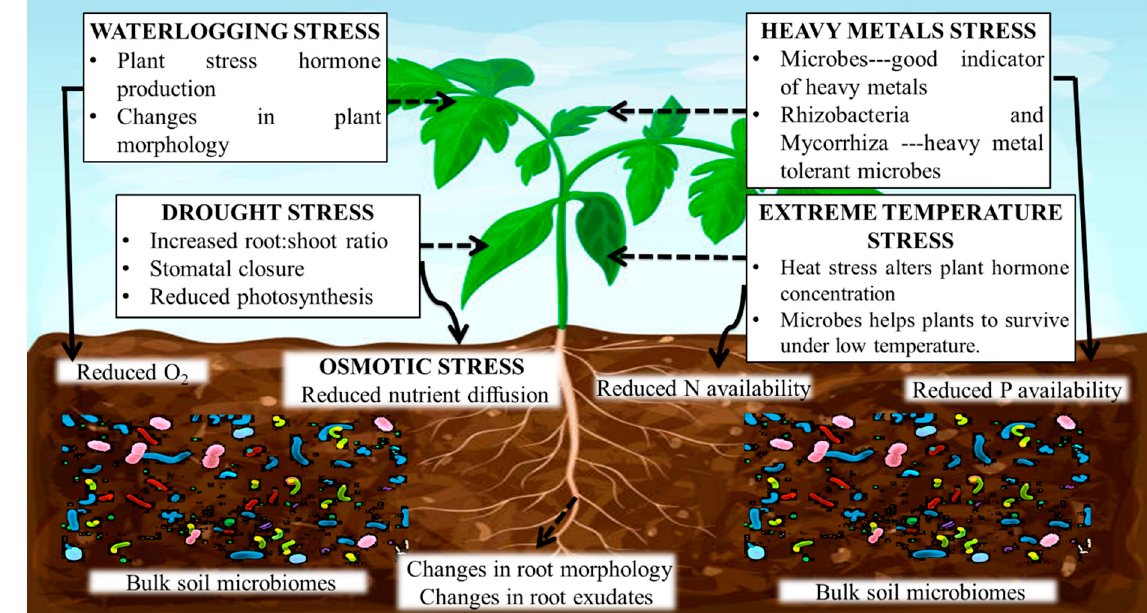
Figure 2. Abiotic stress factors affect the plant microbiomes and their